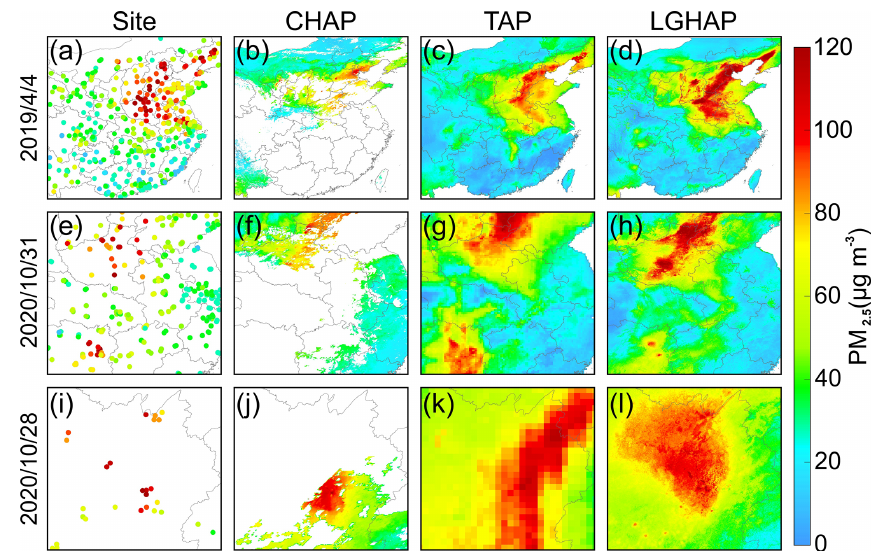
Figure 8. Comparison of PM 2 . 5 distribution reconstructed by different PM 2 . 5 concentration datasets. From the left to right, it shows in situ PM 2 . 5 concentration measurements, CHAP, TAP, and LGHAP, respectively. Dates are given in the format year/month/day.